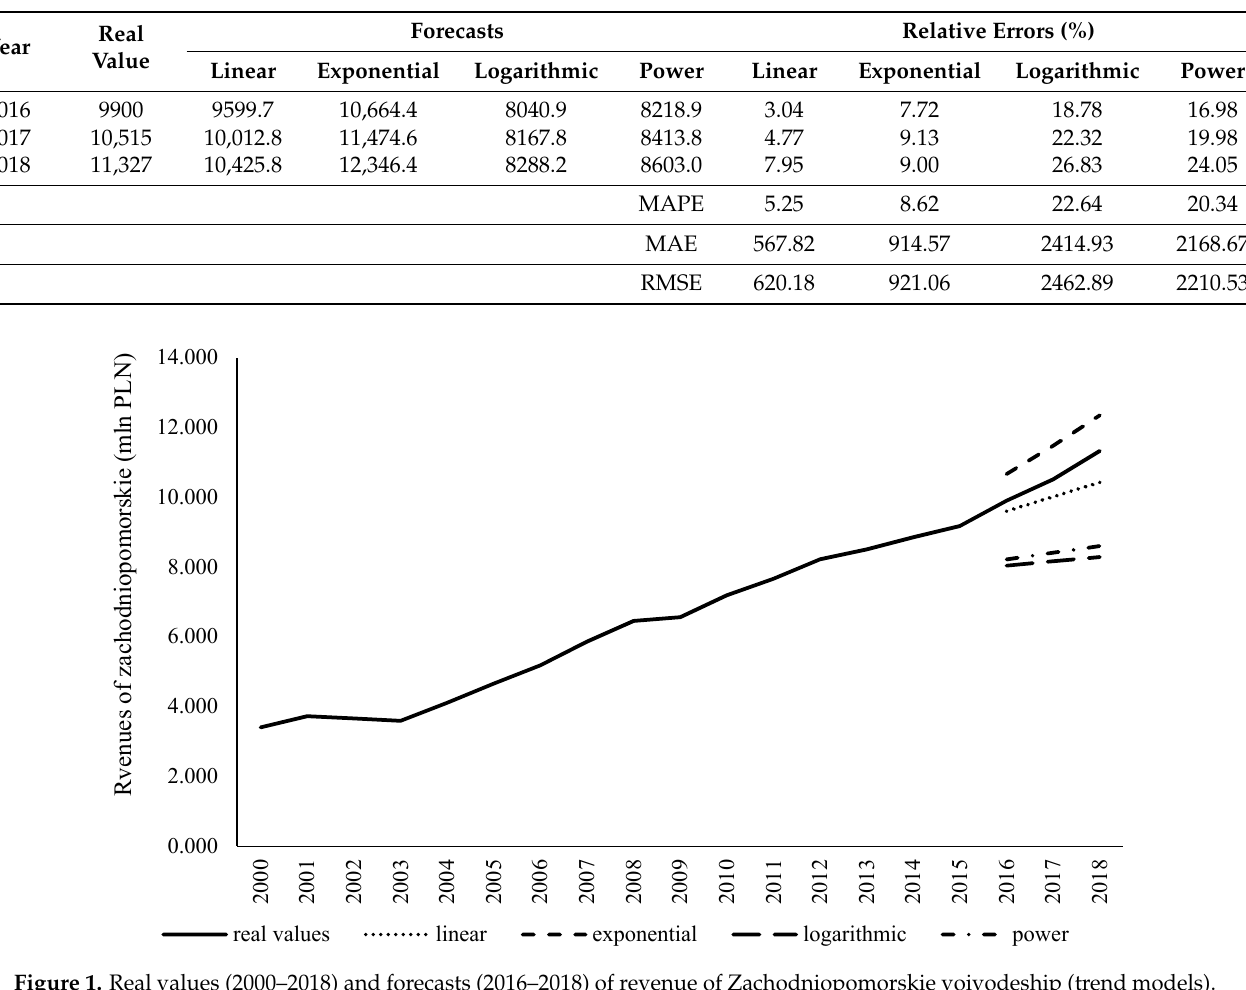
Table 2. Real values, forecasts, relative errors and MAPE’s for revenue of Zachodniopomorskie voivodeship in 2016–2018 (trend models, million PLN).